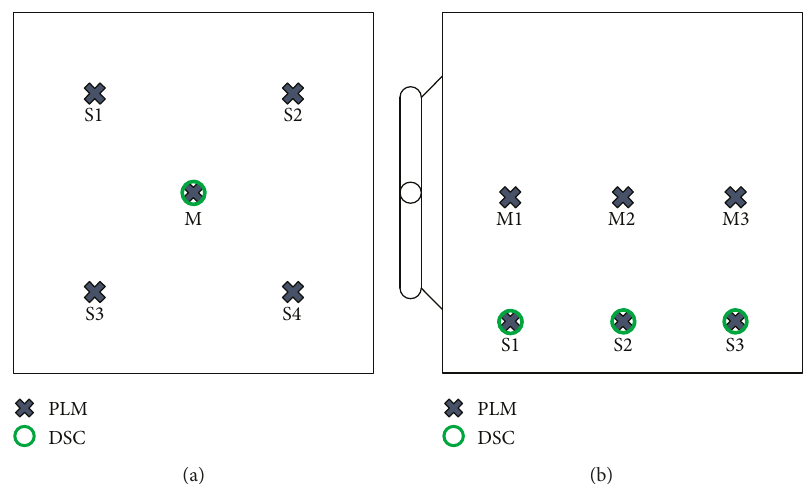
Figure 4: Sample positions used for the PLM studies and the DSC measurements. Compression-molded plate (a) and injection-molded plate (b).